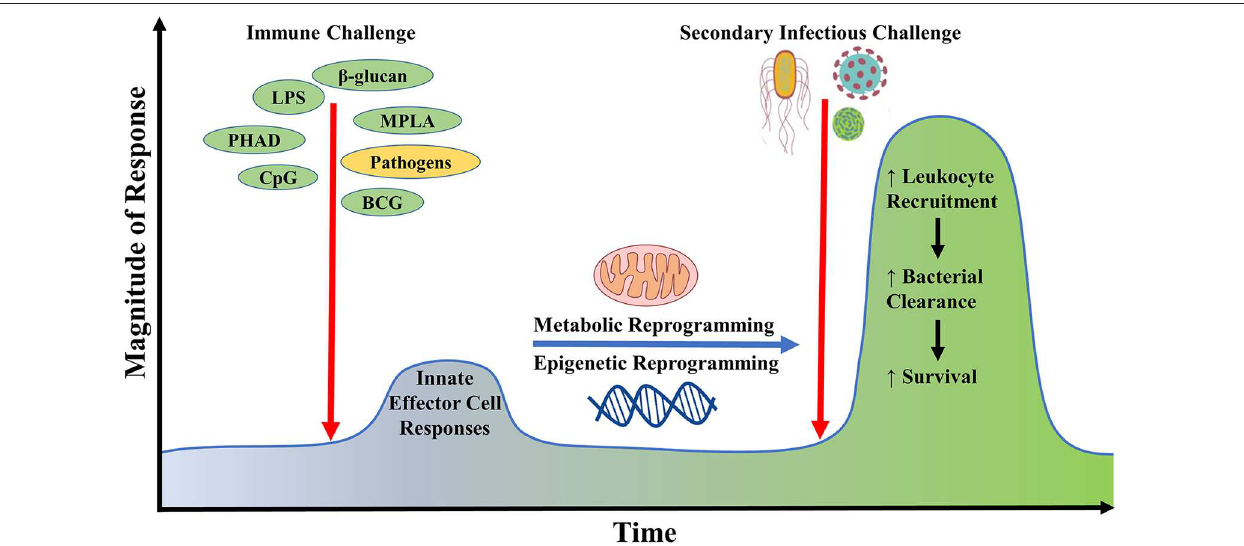
FIGURE 2 | Generation of innate immune memory using microbial ligands. Initial challenge with microbial ligands such as lipopolysaccharide, monophosphoryl lipid A, CpG, β -glucan potently stimulates host innate effector immune responses in cells such as neutrophils, monocytes, and macrophages, leading to the reprogramming of their metabolic and epigenetic status. Upon re-exposure of the initially primed host with a secondary inflammatory stimulus or infectious challenge, there occurs a heightened innate immune response against invading microbes via increased immune cell recruitment leading to improved microbial clearance and survival. This phenomenon is termed as innate immune